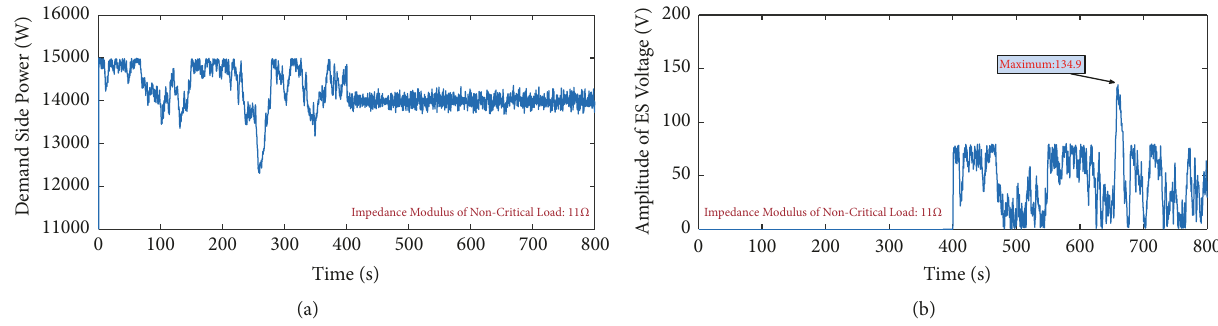
Figure 20: ES in series with a 11 Ω noncritical load. (a) Demand side power. (b) The amplitude of ES voltage.